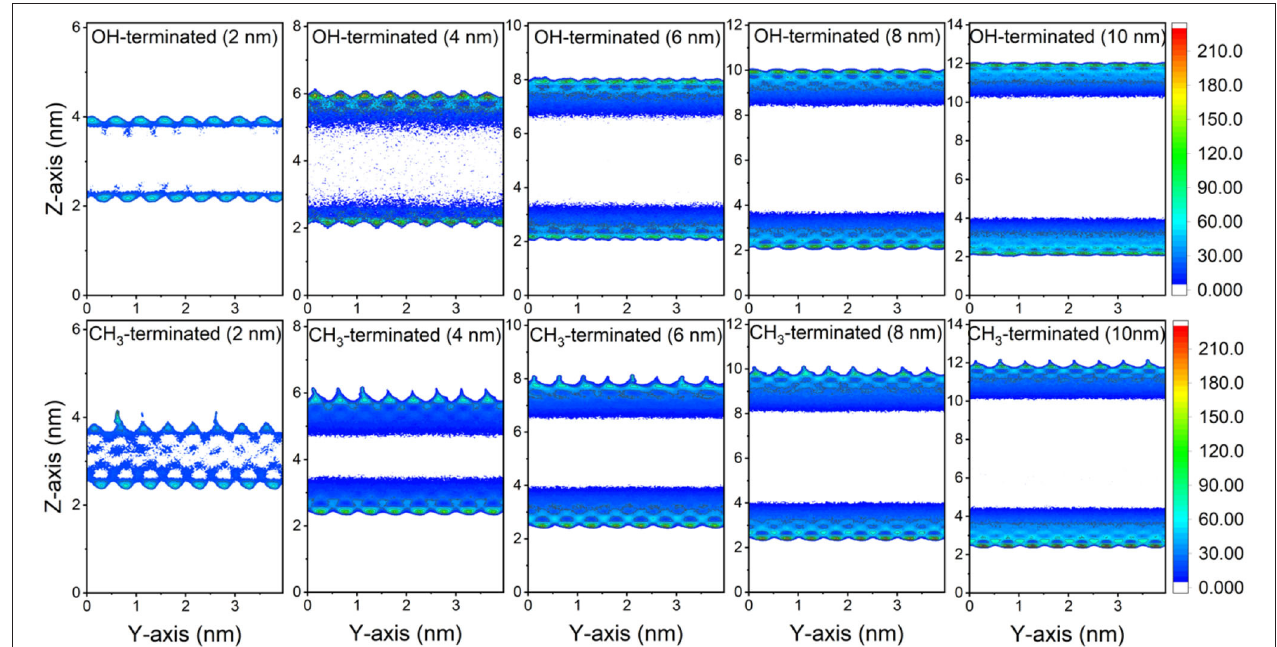
FIGURE 3 | 2D density maps of CO 2 confined in OH-terminated and CH 3 -terminated pores as a function of the pore diameter. The density maps are averaged over the last 10 ns of the simulation times.